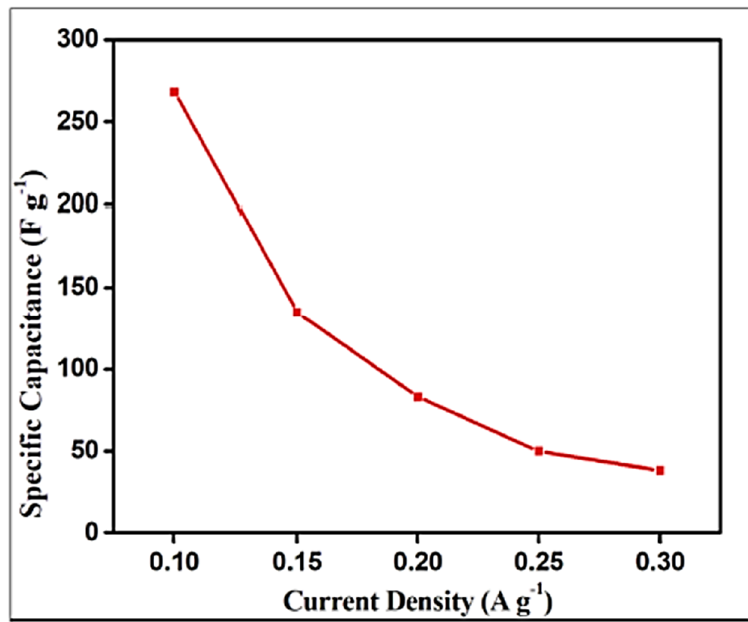
Figure 8. Specific capacitance versus current density of nanocomposite at 0.1 Ag − 1 . (0.1 g ZnO nanoparticles) [124]. Reproduced with permission from Elsevier.